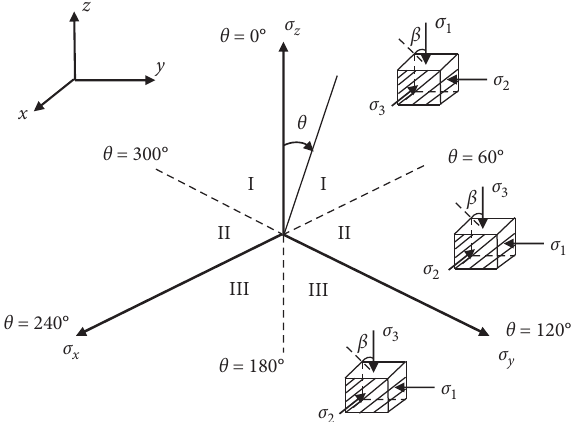
0 and α on the octahedral plane.